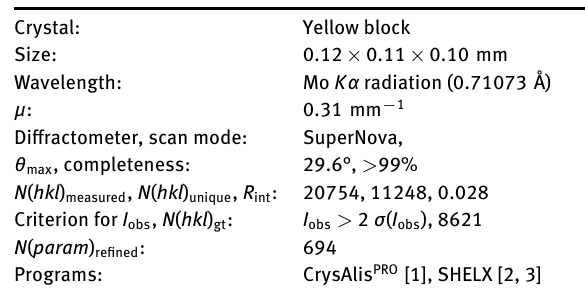
Table 1: Data collection and